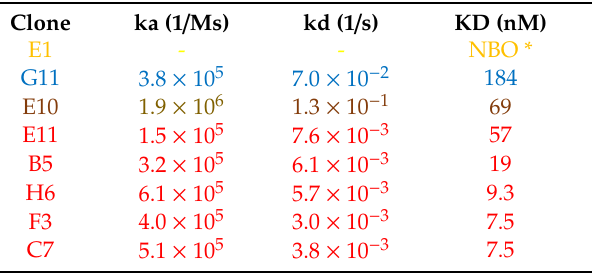
Table 2. Kinetic parameters of Lassa NPn binding